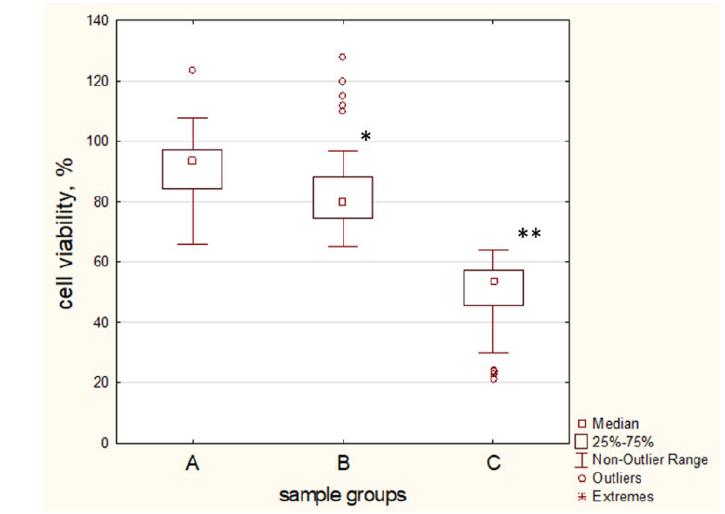
Figure 7. The e ff ect of plasma samples of type 2 diabetes (T2D) patients on the viability of MSCs was assayed by MTT analysis. A—MSCs was treated by 5% v / v plasma samples of healthy donors; B, C—MSCs was treated by 5% v / v plasma samples of T2D patients. Groups were divided by a